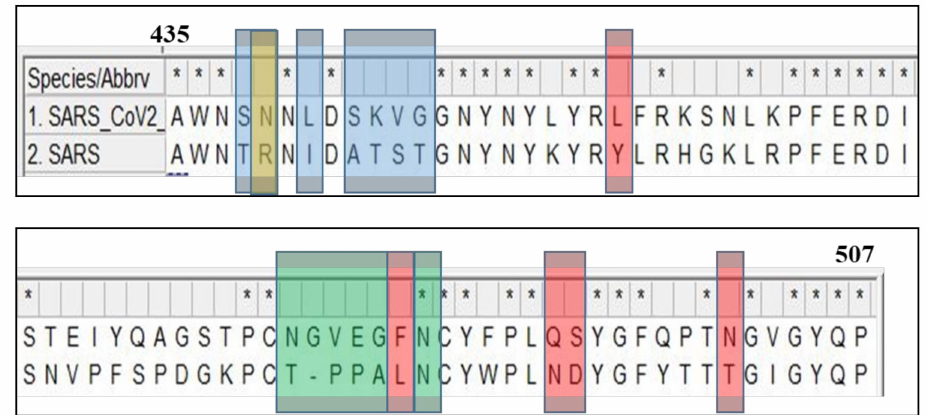
Figure 2. Schematic representation of amino acid sequence alignment of the receptor binding domain (RBD) of the spike glycoproteins of SARS-CoV and SARS-CoV-2. The highlighted regions are responsible for the structural change with following color codes: red, previously identified critical ACE2-binding residues; blue, thesixRBMresiduesthatdi ff erbetweentheSARS-CoV-2wild-typeRBDandSARS-CoV-2 chimeric RBD; yellow, a critical arginine on the side loop of the SARS-CoV RBM that forms a strong salt bridge with ACE2; and green, the residues on the variable loop between two disulfide-bond-forming cysteines in the ACE2-binding